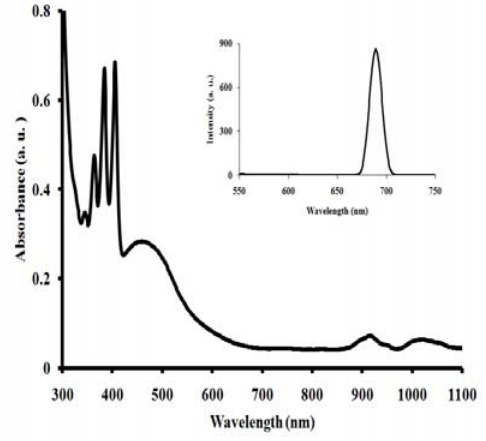
Figure 3. UV - Vis absorption and luminescence (inset) spectra of the [RuL complex at a concentration of 0.001 g/dm 3 in